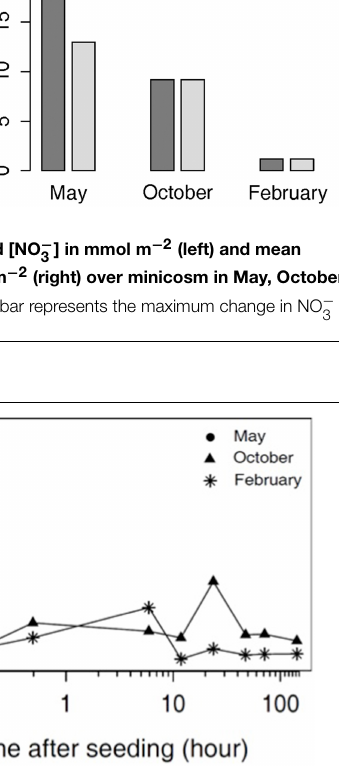
FIGURE 4 | TEP-C concentration [TEP-C] ( μ mol C L − 1 ) in situ in May (circle), October (triangle), and February (star), and temporal evolution of [TEP-C] in October and February after dust